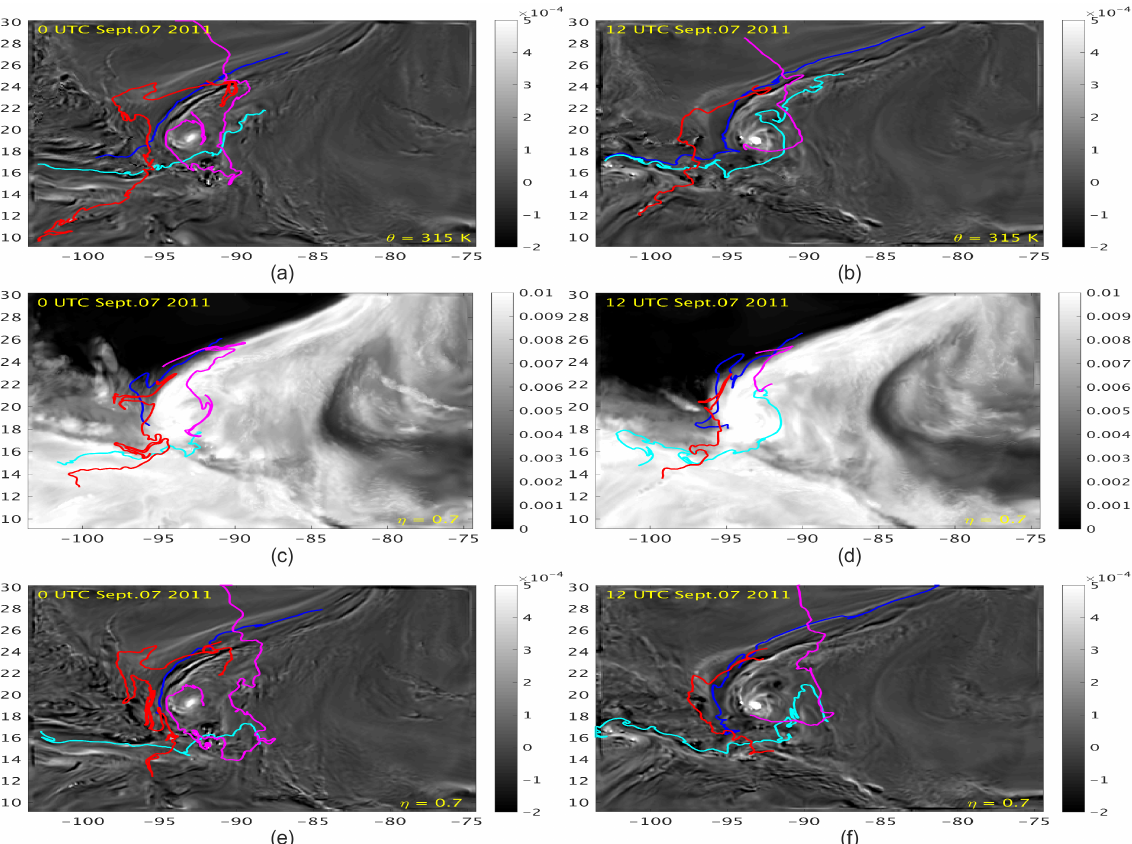
Figure 6. The stable (magenta, red) and unstable (blue, cyan) manifolds from the WRF simulation at the θ = 315K level using varying SSTs are overlaid on the vertical vorticity (s − 1 ) (a–b) , manifolds from the non-divergent velocity field from the WRF varying SST simulation are overlaid on the water vapor mixing ratio (gkg − 1 ) (c–d) , and manifolds at the η = 0 . 7 level using constant SSTs are overlaid on the vertical vorticity (s − 1 ) (e) – (f)